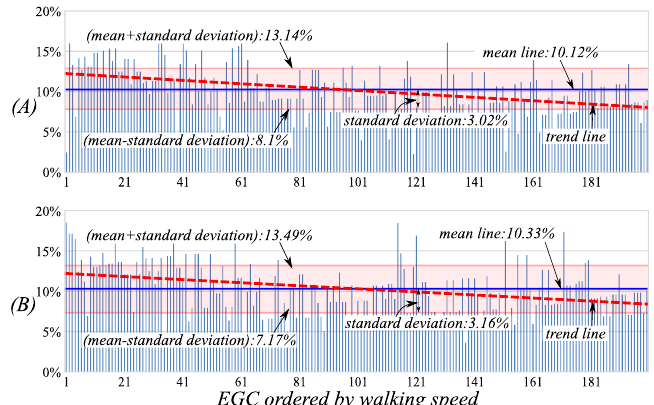
Figure 11. The percentage distributions of the double stance Phase 1 ( DSt1 ) ( A ) and DSt2 ( B ) in the cycle during the EGC. The walking speeds of the EGC are gradually increasing along the horizontal axes.